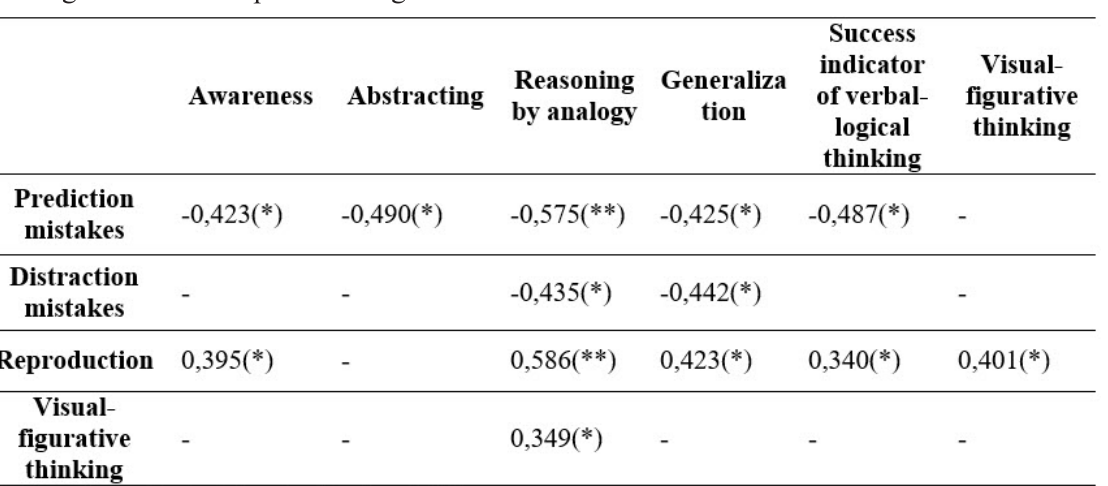
Table 3. Correlations of indicators of predicting, verbal-logical and visual-figurative thinking in children of preschool